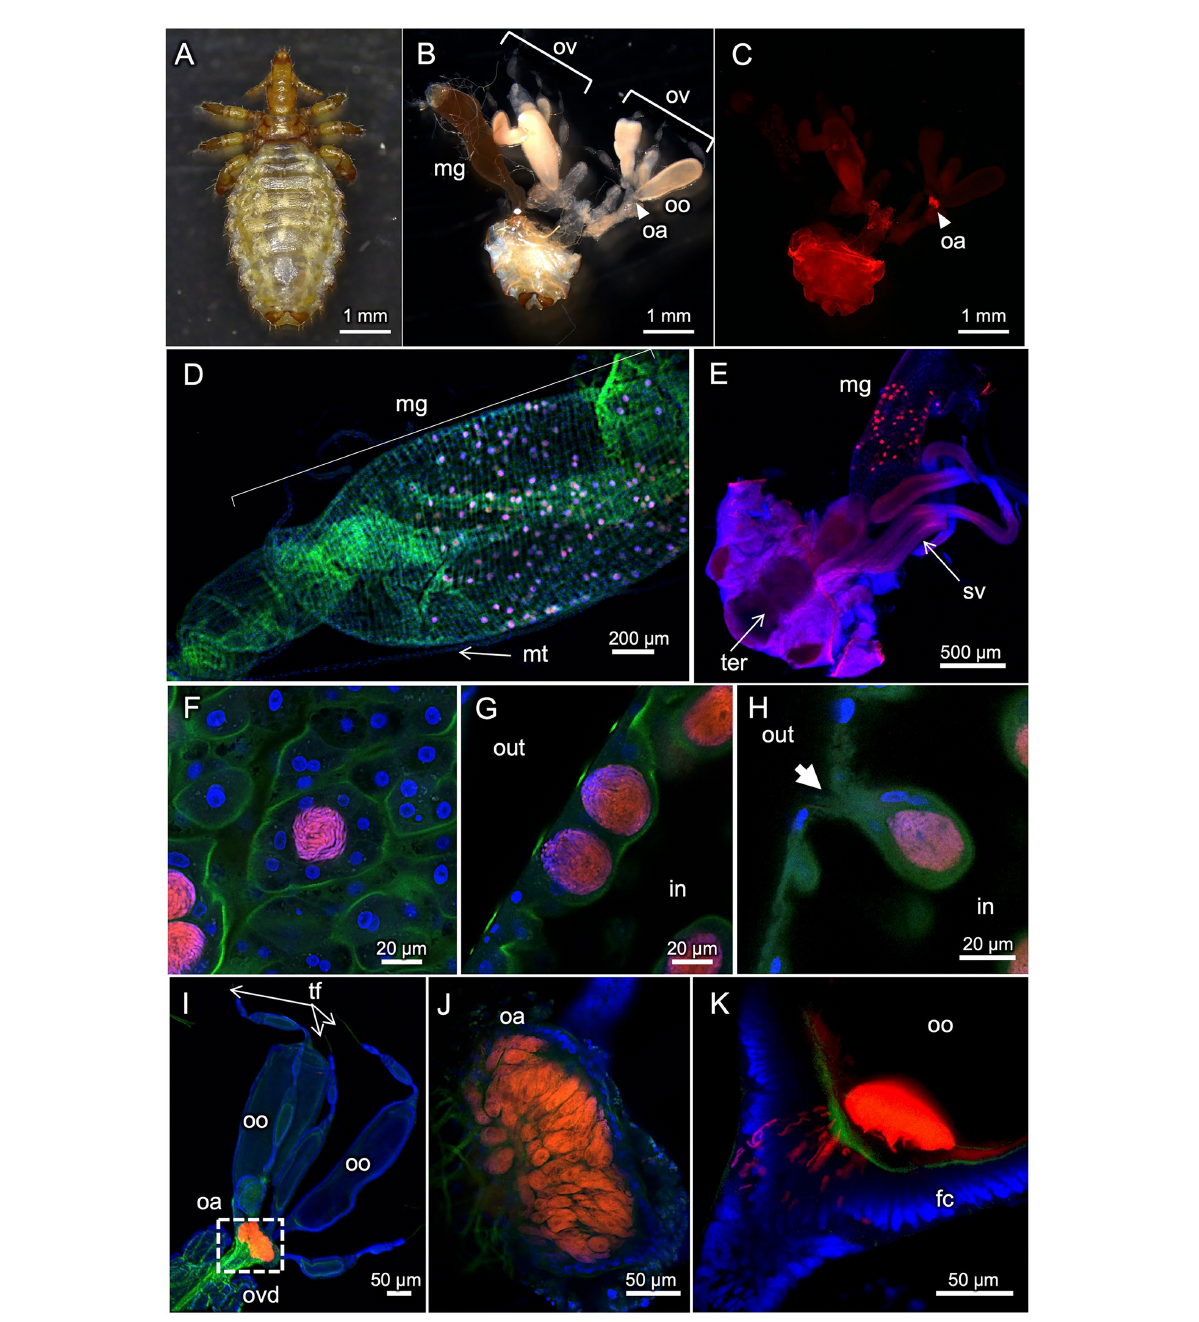
FIGURE 3 FISH visualization of in vivo localization of the primary endosymbiont in H. apri . (A) Dorsal view of an adult female. (B) Internal organs dissected from an adult female. (C–E) Whole-mount FISH visualization of the symbiont in dissected organs. (C) Localization of the symbiont in the ovarial ampulla of an adult female. The sample is the same as ( B ). (D) Scattered localization of the symbiont across the midgut epithelial region of an adult female. (E) Similar localization pattern of the symbiont in the midgut epithelium of an adult male. (F–H) Magnified confocal images of the symbiont in the midgut epithelium. (F) Optical section image parallel to the epithelial plane. (G) Optical section image perpendicular to the epithelial plane. (H) Optical section image crossing the epithelial plane, in which a bacteriocyte-like structure with an external pit is seen. The bacteriocyte-like structures are actually extracellular cavities round in shape, full of tubular bacterial cells, and surrounded by the midgut epithelial cells. (I–K) Localization of the symbiont in ovaries and oocytes. (I) Localization of the symbiont in the ovarial ampulla located at the interface of lateral oviduct and oocyte-containing ovarioles. (J) Optical section image of the ovarial ampulla, in which peculiar host cells are densely populated by the symbiont cells. (K) Optical section image of the posterior pole of an oocyte, to which the tubular symbiont cells are infecting through the follicle cell layer. Abbreviations: fc, follicle cell layer; hg, hindgut; mg, midgut; mt, Malpighian tubule; oa, ovarial ampulla; oo, oocyte; ov, ovary; ovd, oviduct; sv, seminal vesicle; ter, tergite; tf, terminal filament. In (B,C) , arrowheads indicate the location of the ovarial ampulla. In (G,H) , “out” and “in” indicate outside and inside of the midgut, respectively. In (H) , an arrow highlights a pit associated with the bacteriocyte-like